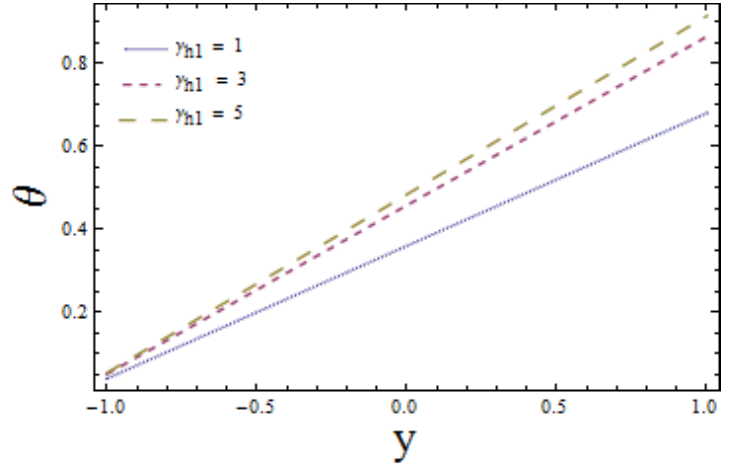
Figure 7. Temperature θ versus y for γ h 1 when (cid:101) = 0.2, x = 0.1, t = 0.1 and γ h 2 =